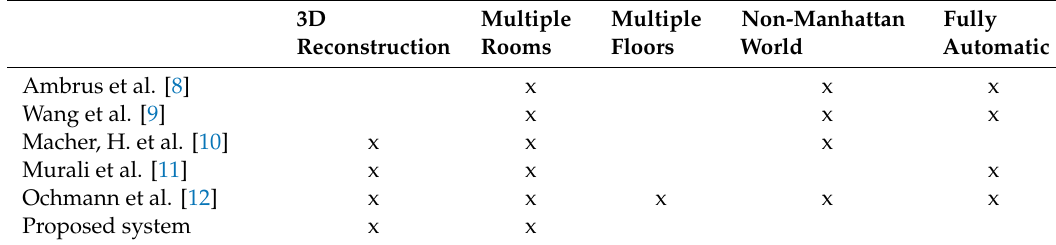
Table 1. Comparison of the state of the art of geometry reconstruction from point clouds.